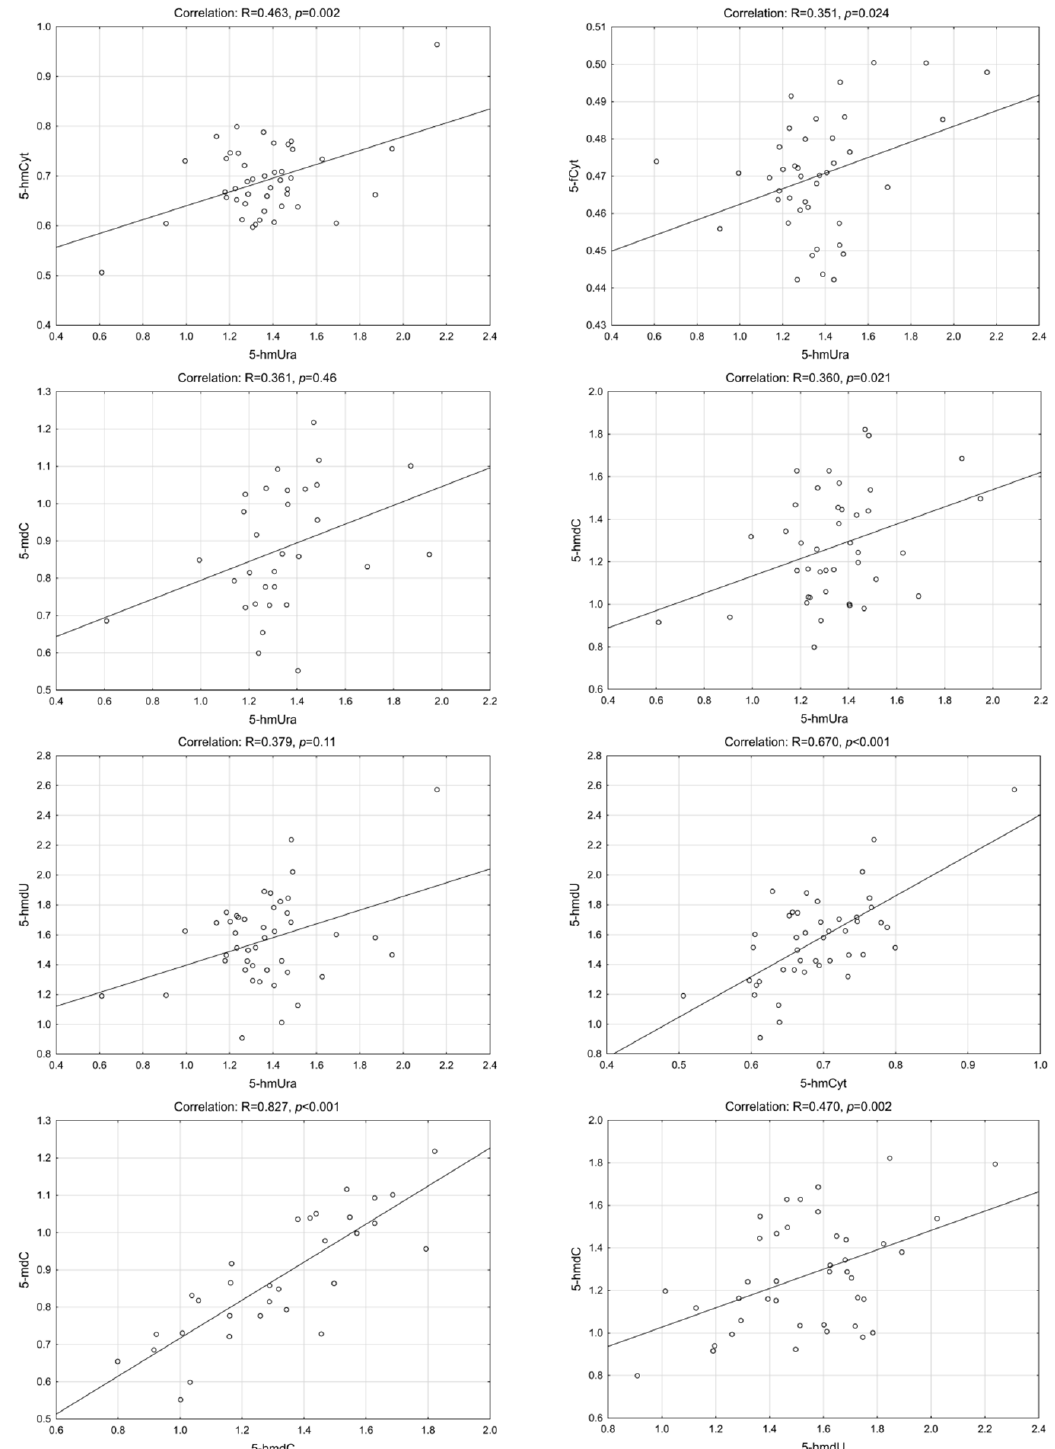
Figure 4. Selected correlations between the levels of DNA epigenetic modifications in urine— adenoma group. 5-hmCyt: 5-hydroxymethylcytosine; 5-hmUra: 5-hydroxymethyluracil; 5-mdC: 5- methyl-2′-deoxycytidine; 5-hmdC: 5-(hydroxymethyl)-2′-deoxycytidine; 5-hmdU: 5- (hydroxymethyl)-2′-deoxyuridine; 5-fCyt: 5-formylcytosine.